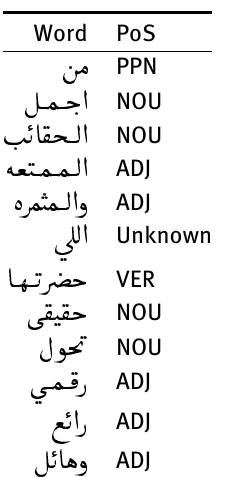
Table 3: PoS for